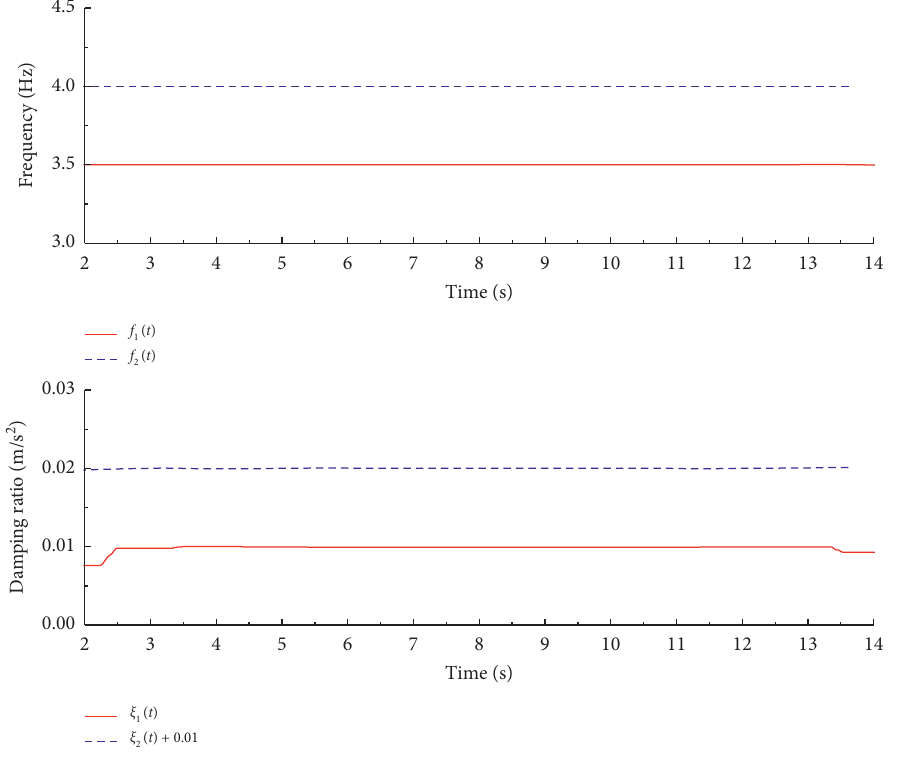
Figure 4: Instantaneous frequency and damping ratio. Table 1: Identification results for various damping ratios.